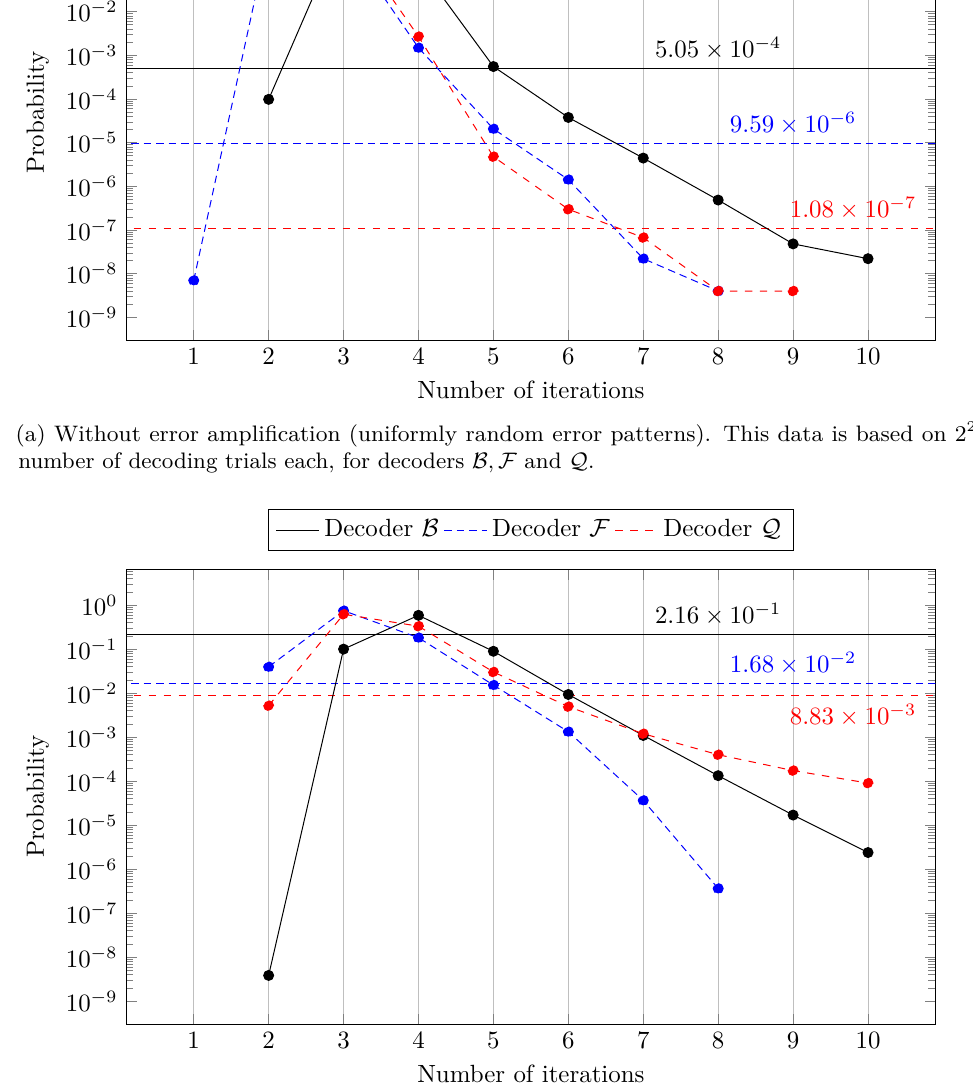
Figure 2: In these logarithmic plots the markers indicate by what probability (y-axis) each of the implementations can decode a message using (exactly) a certain number of iterations (x-axis). The horizontal lines indicate the decoder failure rate for each decoder